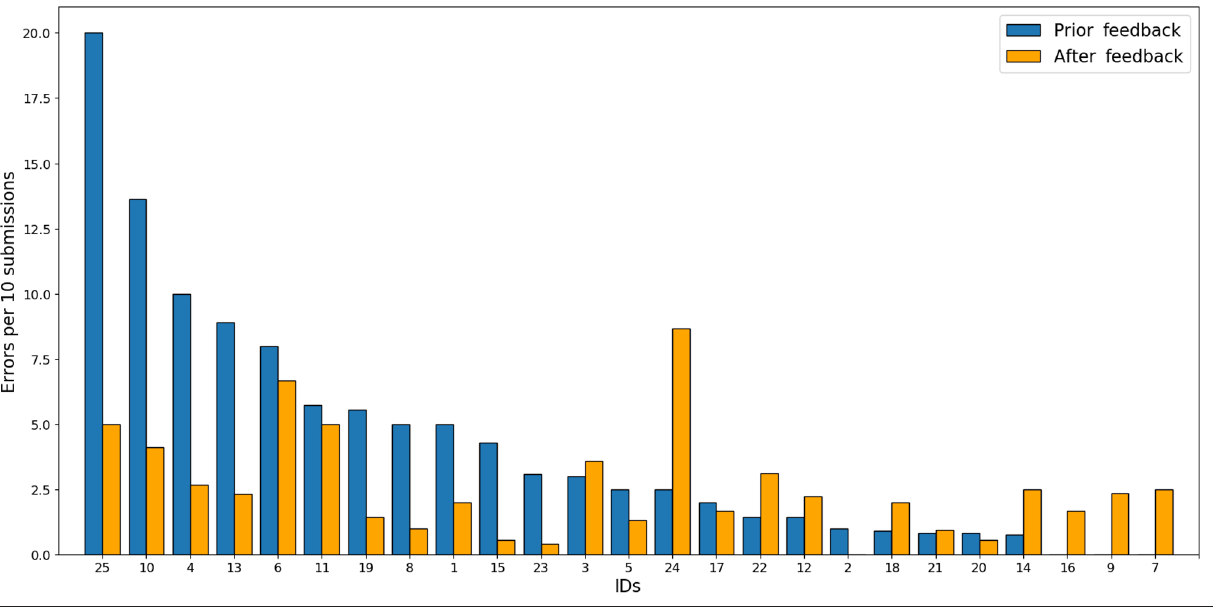
Figure 3 The average number of errors per 10 reports for each of the 25 citizen scientists, both before and after the personalized feedback. Note that in each report, a maximum of eight potential errors can be